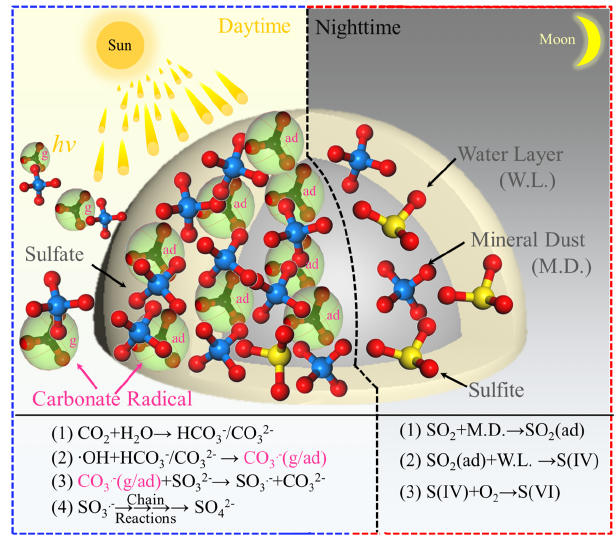
Figure 11. Schematic of the sulfate formation in the presence and absence of a carbonate radical. Note that g and ad represent gas phase and adsorbed carbonate radical ions,